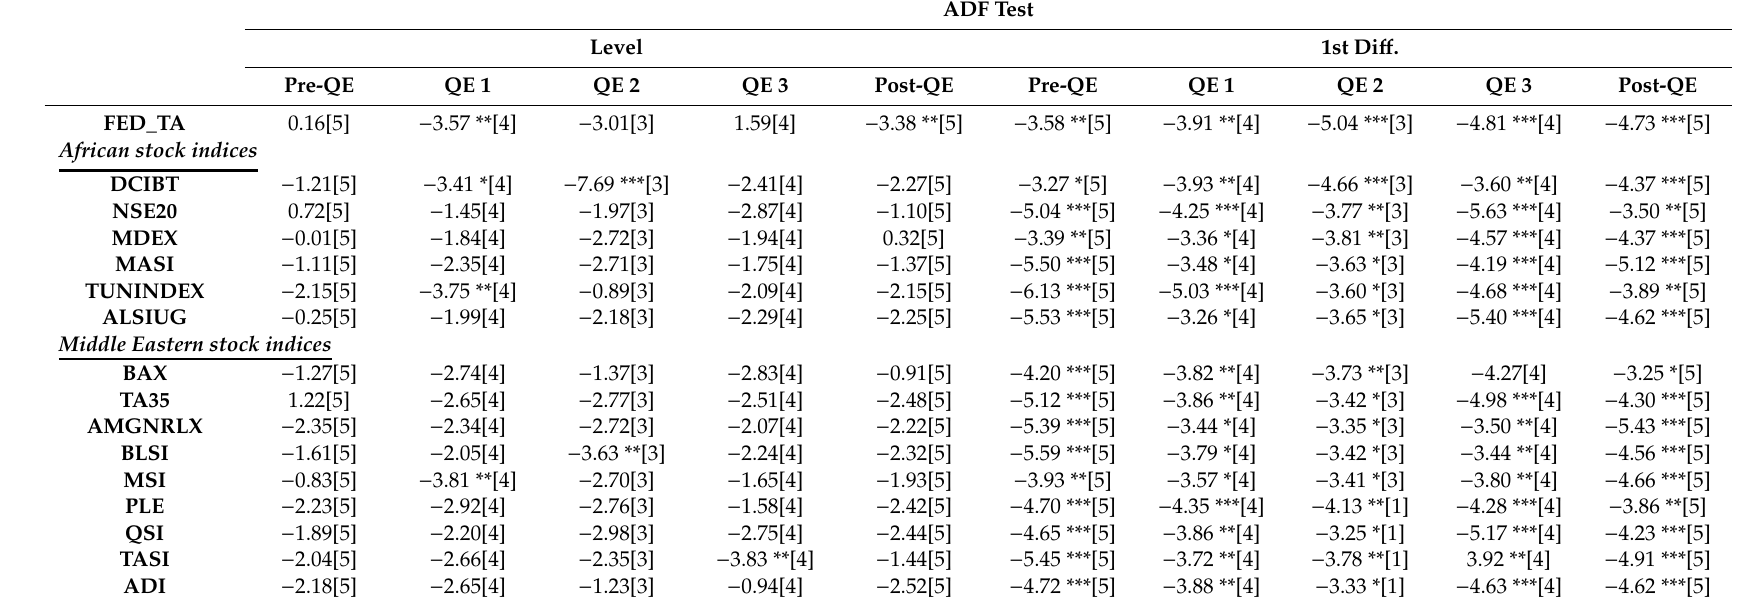
Table 3. Unit roots tests results based on the augmented Dickey–Fuller